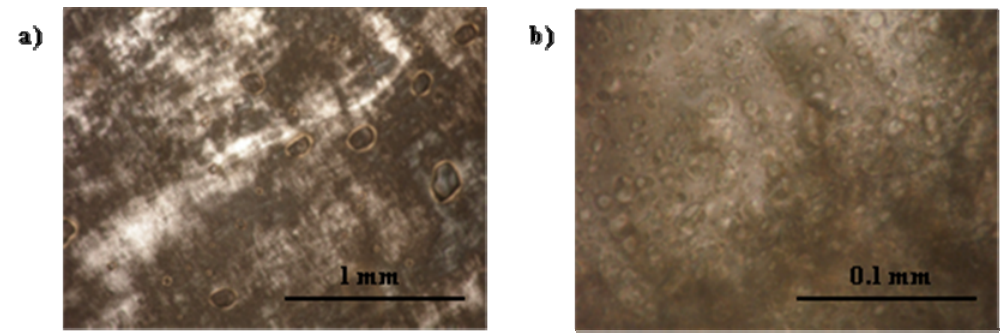
Figure 9. Cross-polarizer micrographs of 20% gelatin MBG formulated with a μ E containing 80% water (system of Figure 8b), 10% oil and a 10% of a mixture of 1:2:0.8:1.2 weight ratio of lecithin: PEG-6-caprylic/capric glycerides:decaglycerol